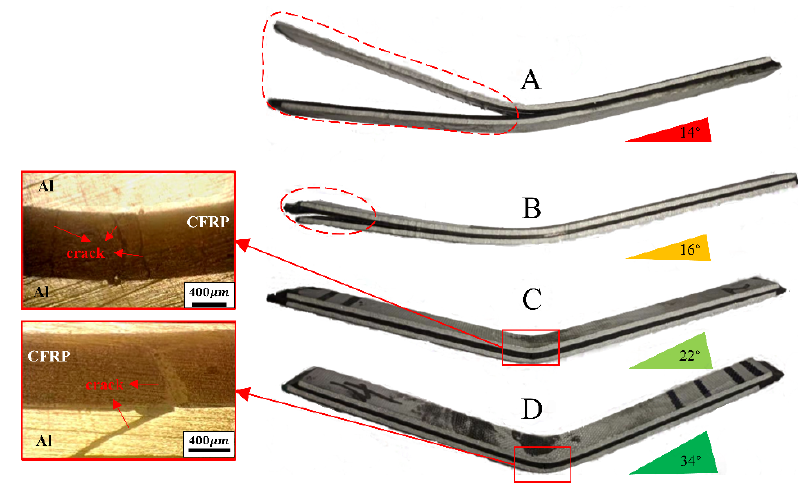
Figure 13. Bending failure forms of four laminates.